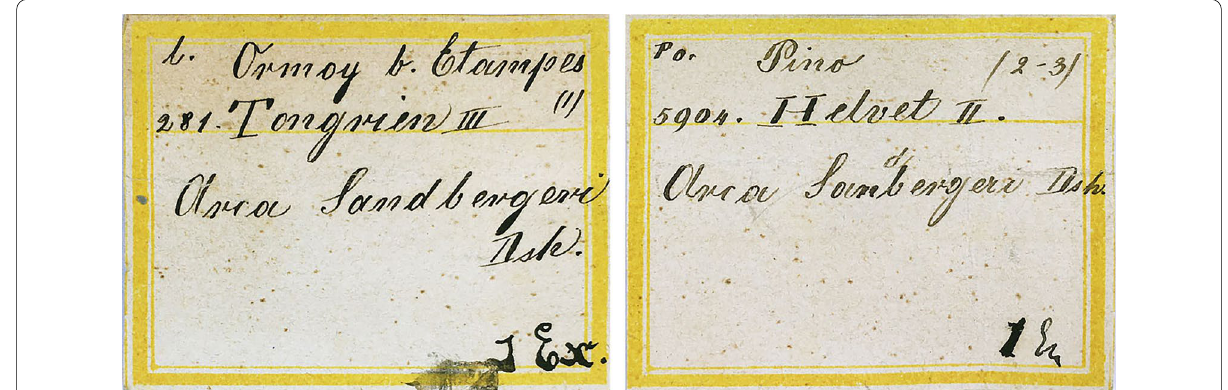
Fig. 9 Two examples of “old” labels, in this case of Arca sandbergeri Deshayes, 1858. For further explanations, see text